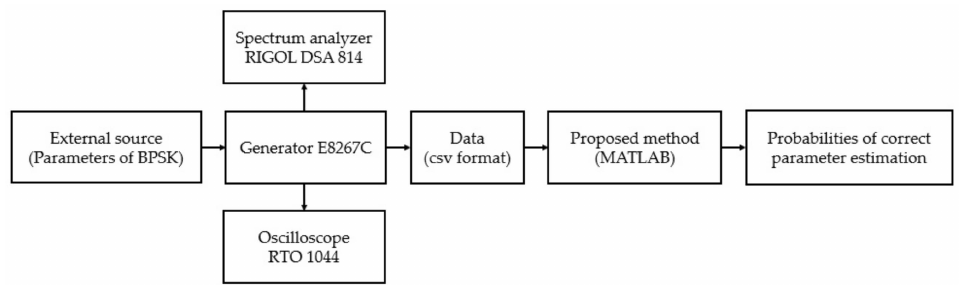
Figure 7. Block diagram of the experimental test setup for verifying the functionality of the pro- posed technique.